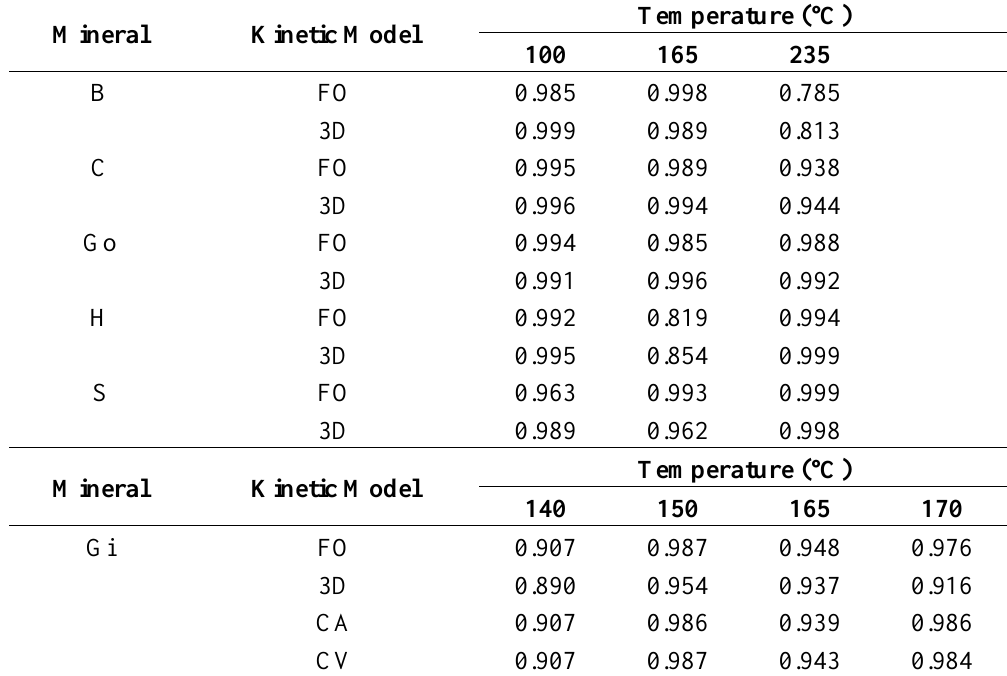
Table 6. Coefficient of determination ( r 2 ) values for least square lines fitted to mineral precipitation or dissolution data under a first-order surface control kinetic model (FO), 3D diffusion control kinetic model (3D), contracting area model (CA), and contracting volume model (CV). Mineral names are abbreviated as follows: Gi—gibbsite; B—boehmite;